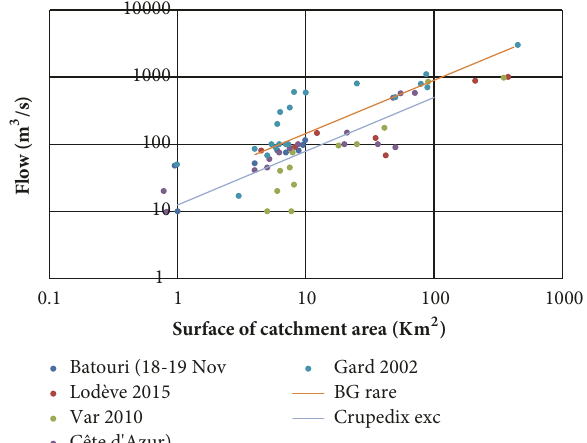
Figure 6: Comparison of flows obtained for different recent postevent survey and for different flood predetermination estima- tion.